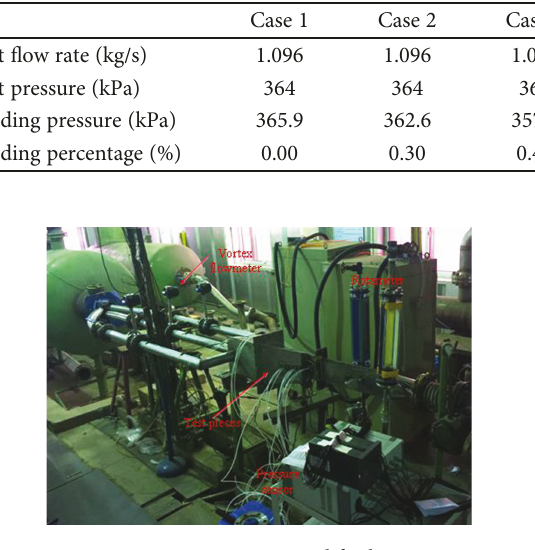
/ H = 1 20, T = 150 ° C ). 2 1